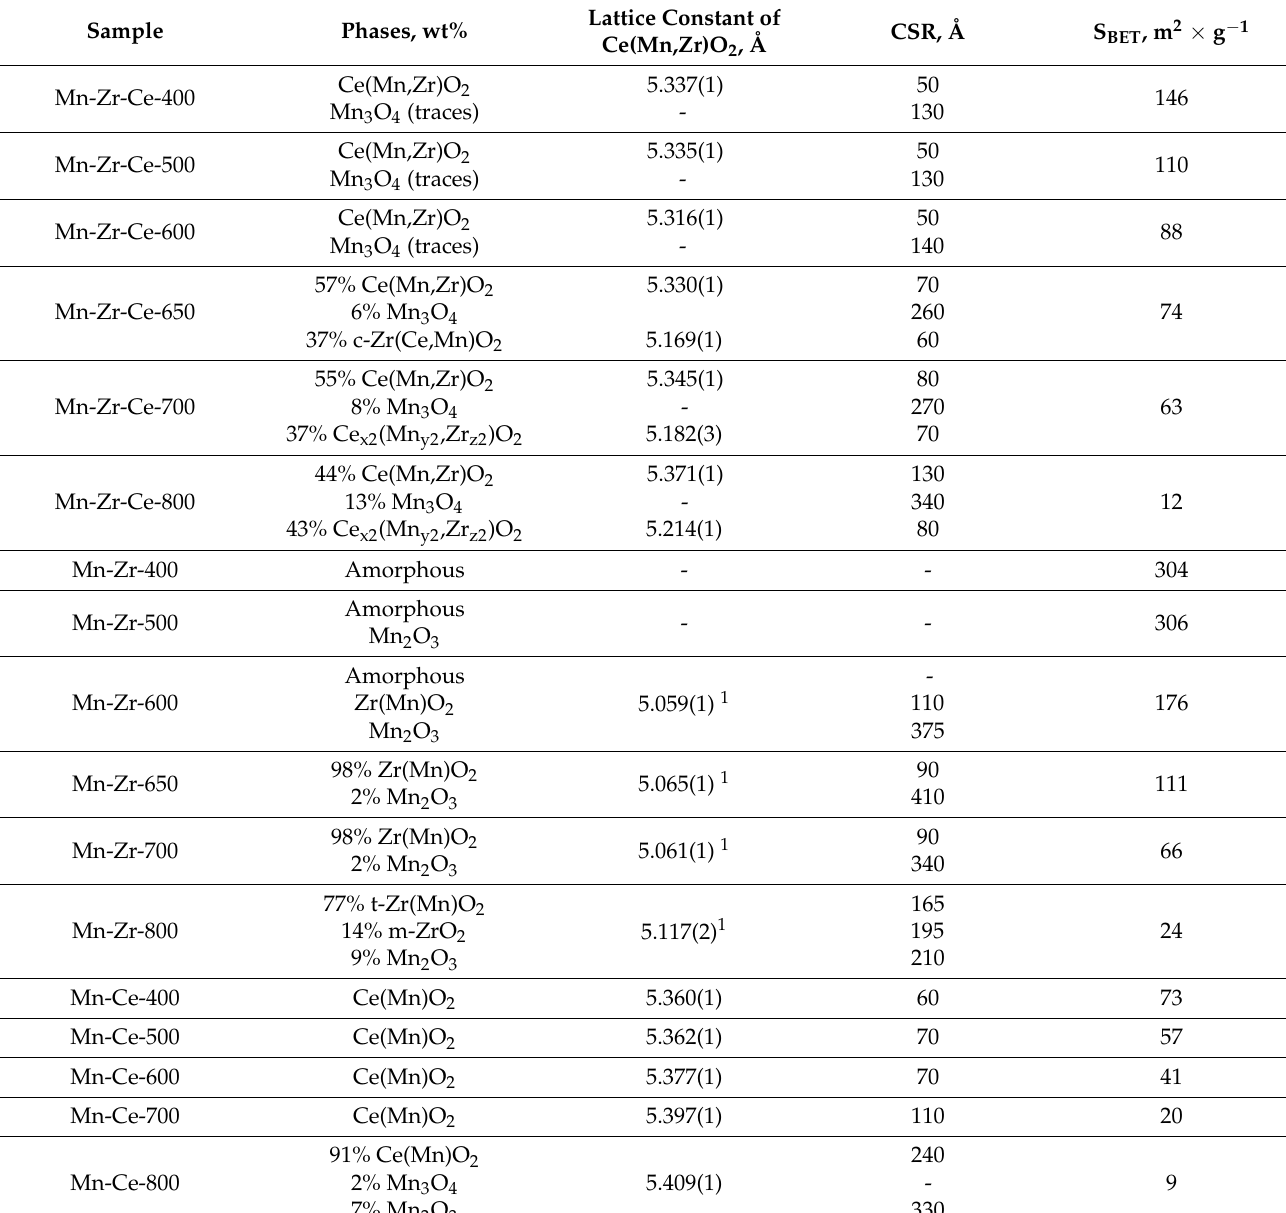
Table 1. Structural and microstructural characteristics of Mn-Ce, Mn-Zr and Mn-Zr-Ce